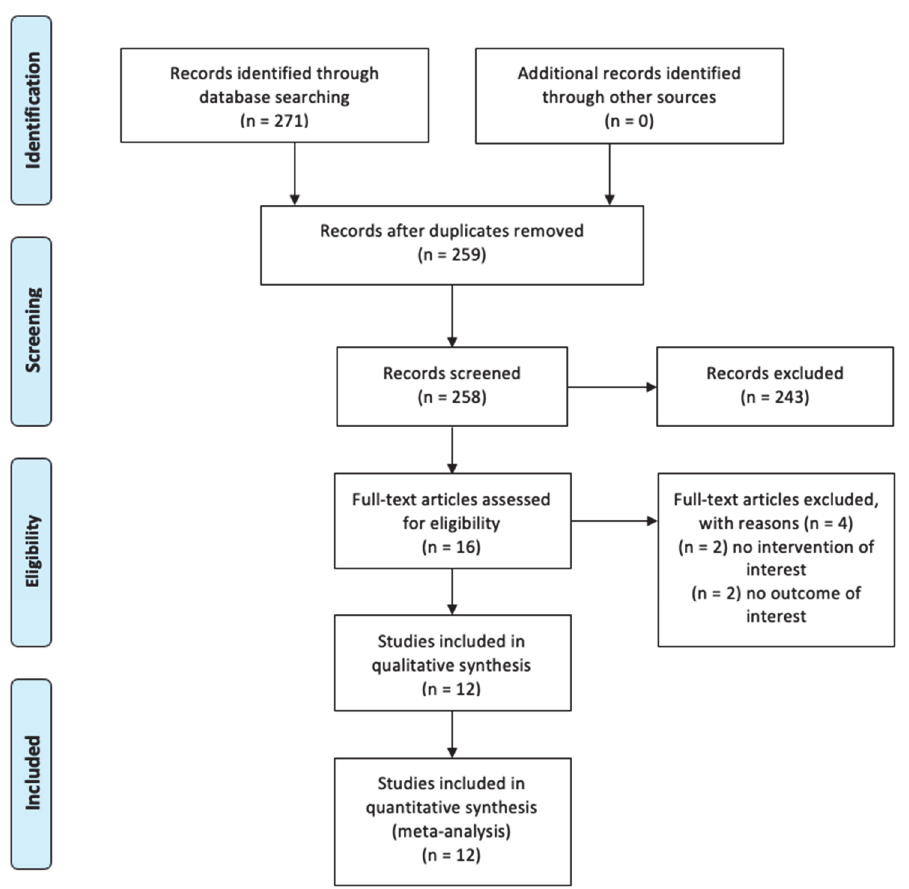
Figure 1. Flow diagram of search strategy according to PRISMA statement.